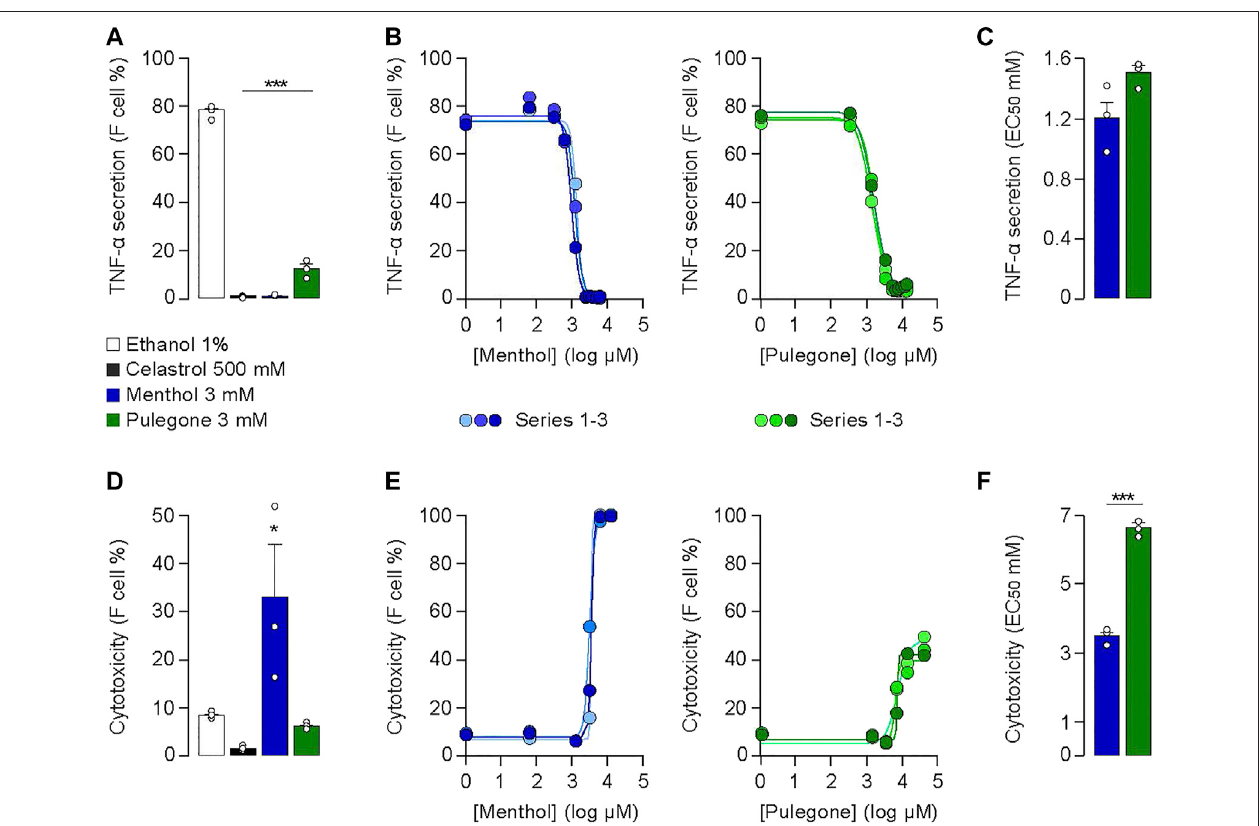
FIGURE 2 | (A) Anti-in fl ammatory activities and (D) cytotoxicities of pulegone and menthol at 3 mM in 1% ethanol after 4 h LPS-stimulation of THP-1 cells. Experiments ( n (cid:1) 3) were conducted on the same 96-well plate to compare to the same negative control (1% ethanol) (*** p < 0.001; ** p < 0.01; * p < 0.05). Celastrol at 500 mM was used as the positive control. (B) One-way ANOVA F(3;8) (cid:1) 1,031.6, p < 0.001, (E) one-way ANOVA F(3;8) (cid:1) 6.22 p (cid:1) 0.05). Dose-response curves of (B) anti-in fl ammatory activity and (E) cytotoxicity of pulegone and menthol after 4 h LPS-stimulation of THP-1 cells. Concentration range: 0.03 – 13 mM. Each concentration was tested in triplicates on the same 96-well plate. (C,F) EC 50 values calculated by the dose-response curves of (C) the anti-in fl ammatory activity and (F)